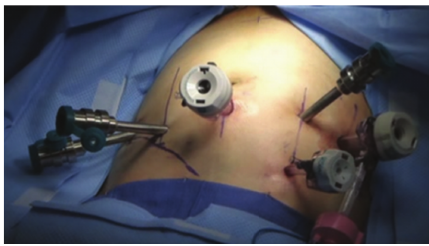
Figure 1: Intraoperative photograph of port placements.